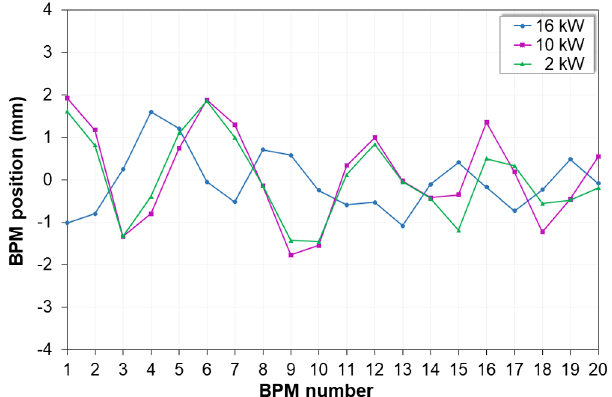
RFQ.FIG. 15. Beam position in the vertical plane along the SC linac for 16 kW (blue), 10 kW (violet), and 2 kW